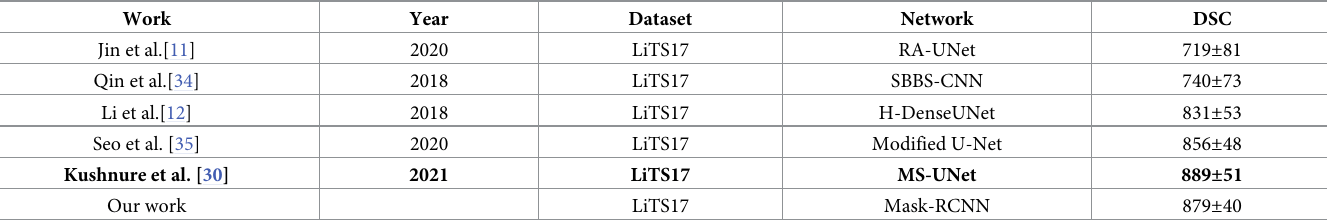
Table 7. Comparison of our work to liver tumour segmentation state-of-the-art methods. All results are multiplied by 1000 and the bold font highlights the best results.